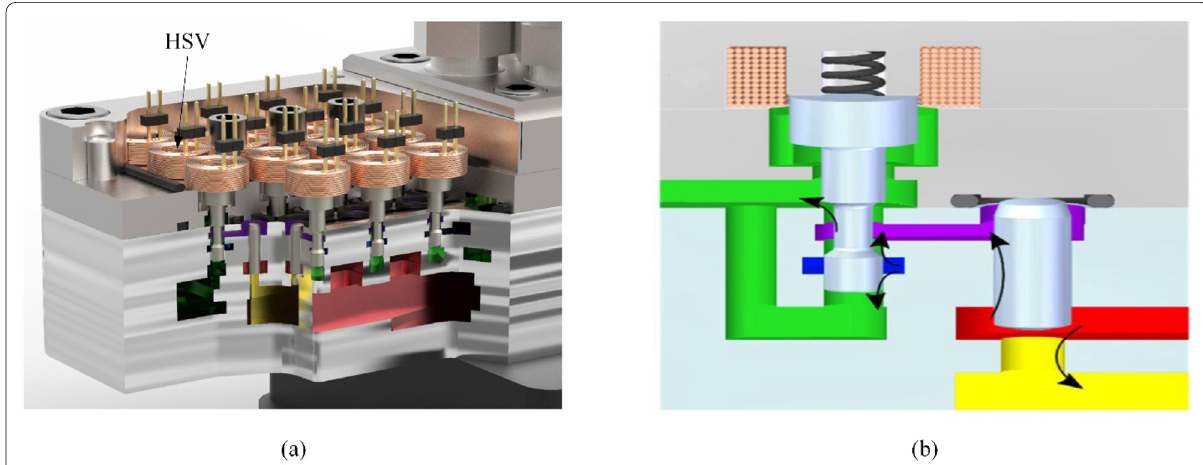
Figure 22 Valve system with multiple pilot operated HSVs designed by Lantela et al.: a prototype, b utilized